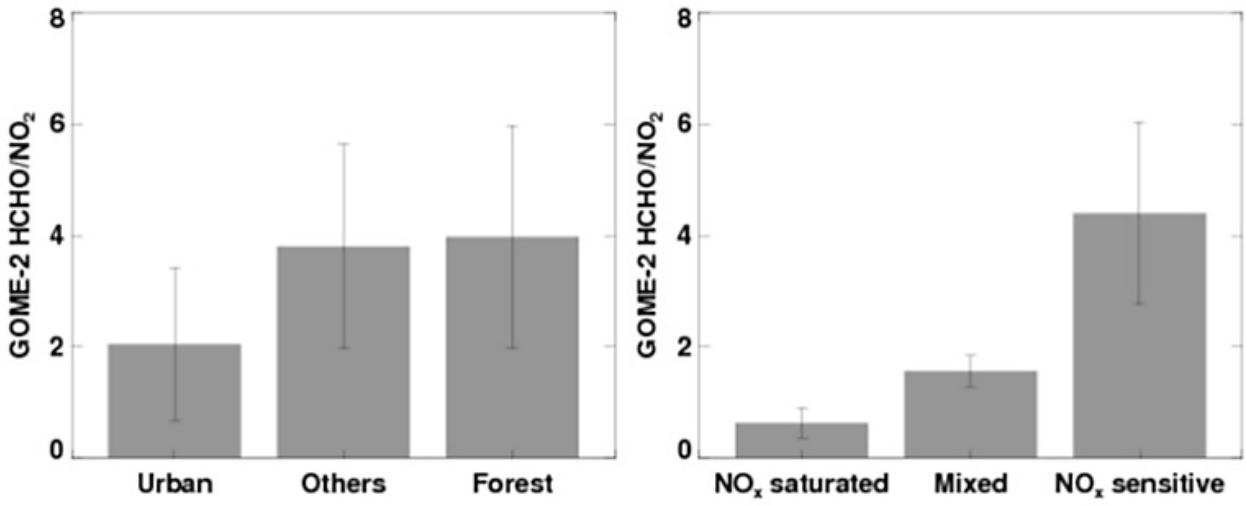
Fig. 4. The ratio of GOME-2 HCHO columns to NO 2 columns over AVHRR-derived geographical regions (i.e., urban, others, and forest regions, left panel) and GOME-2 derived chemical regimes (i.e., NO x -saturated, mixed, and NO x -sensitive regimes, right panel) for August 2009. The bar represents the standard deviation of GOME-2 HCHO/NO 2